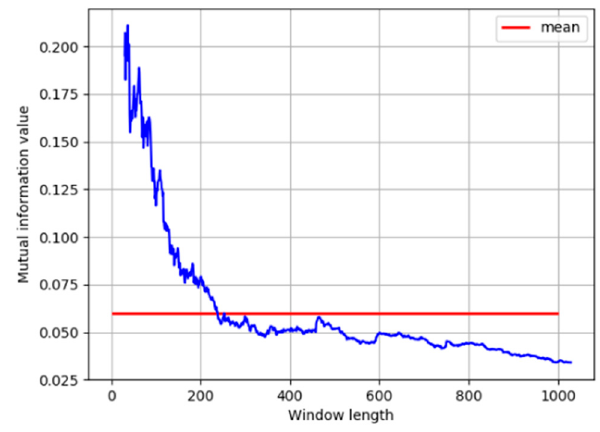
Figure 5. MI in different window lengths.